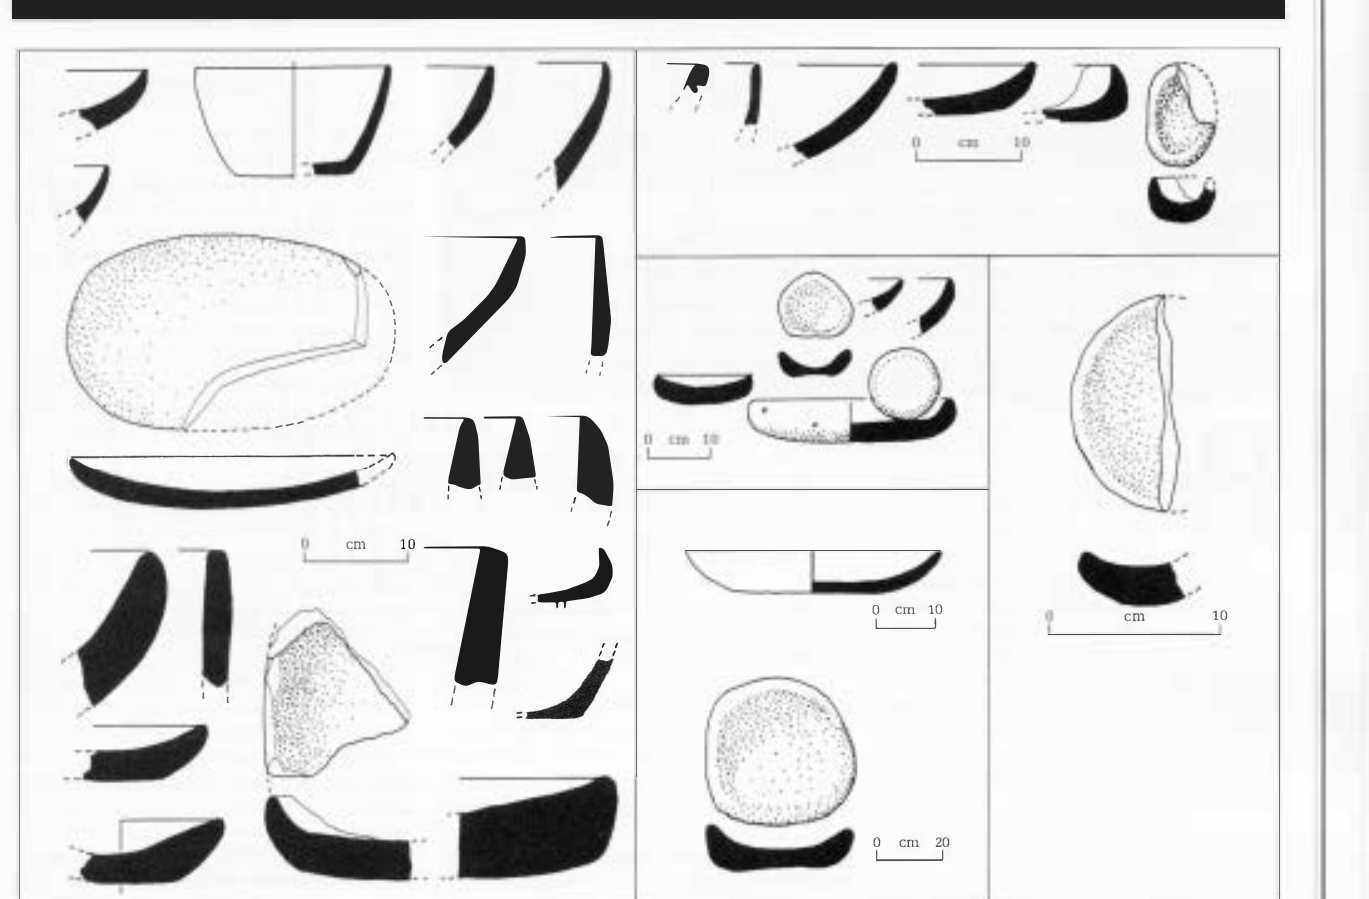
China (Zhoukoutien], Hungary (Vertesszi:illi:is) and Britain (Beeches Pit). But all these tantalizing hints are ambig­ uous: the fire features and burnt material are not all in situ and some cannot defi­ nitely be linked to human activity. In Southwest Asia, no firm evidence for fire control has been found at Lower Palaeo­ lithic sites. 7. Early fireplaces have been discovered at Middle Palaeolithic sites in France, Israel, Jordan, Lebanon, Syria, Turkey, Iraq and Iran; see for exampleS. James, "Hominid use of fire in the Lower and Middle Pleis­ tocene", Current Anthropology 30, 1-26,